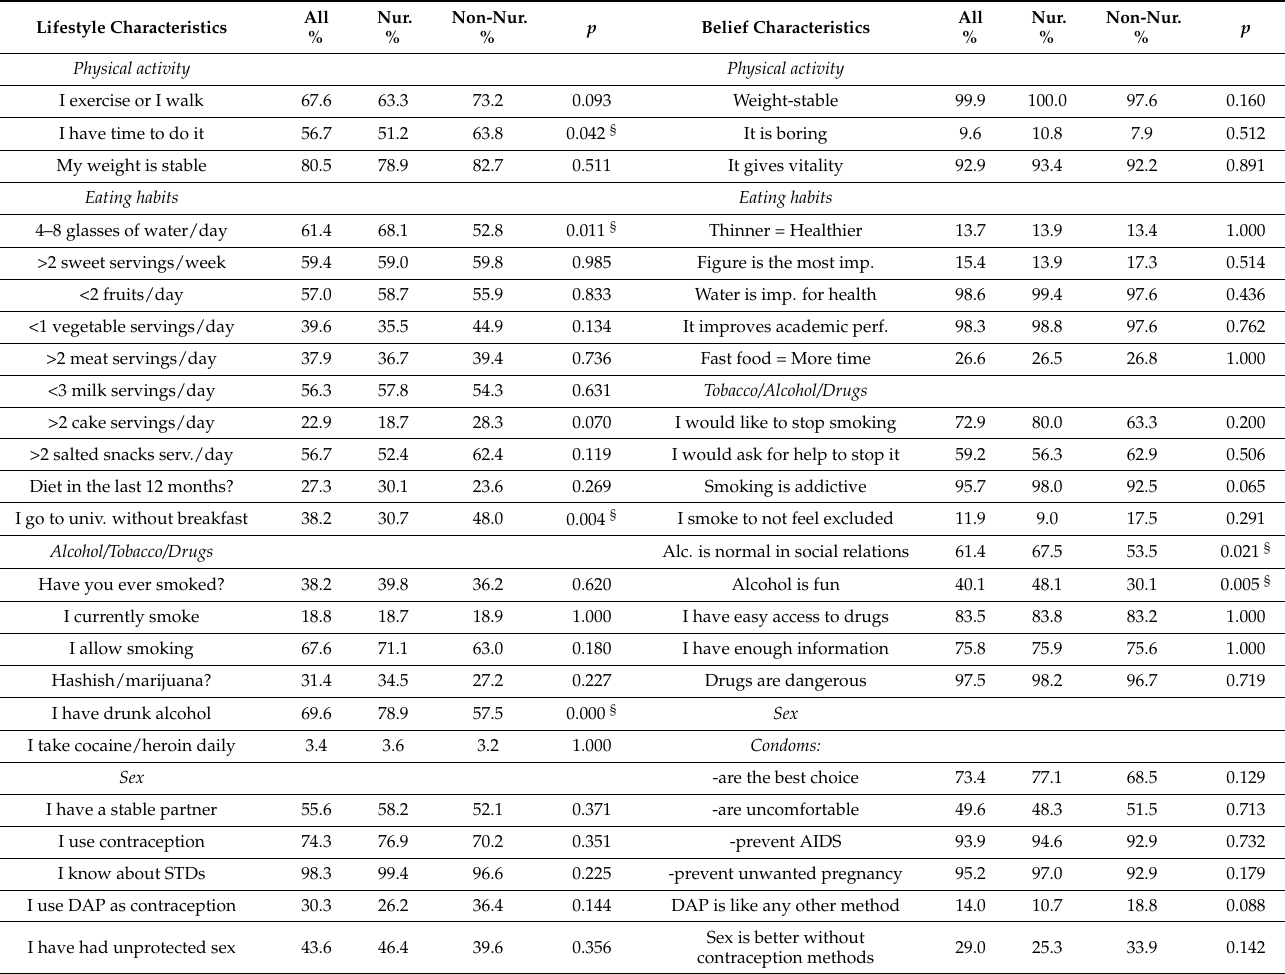
Table 3. Lifestyle and health beliefs of